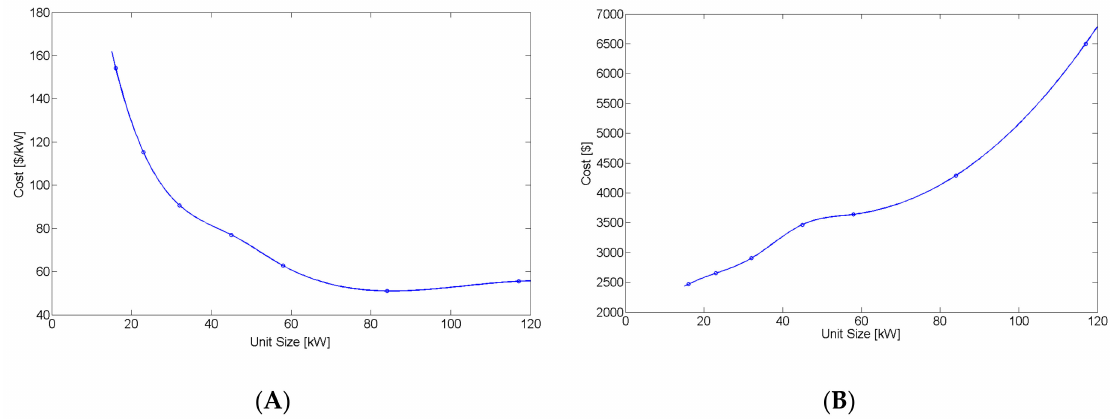
Figure 4. Costs of a gas-fired boiler as a function of its size. ( A ) cost per kW; ( B ) cost per